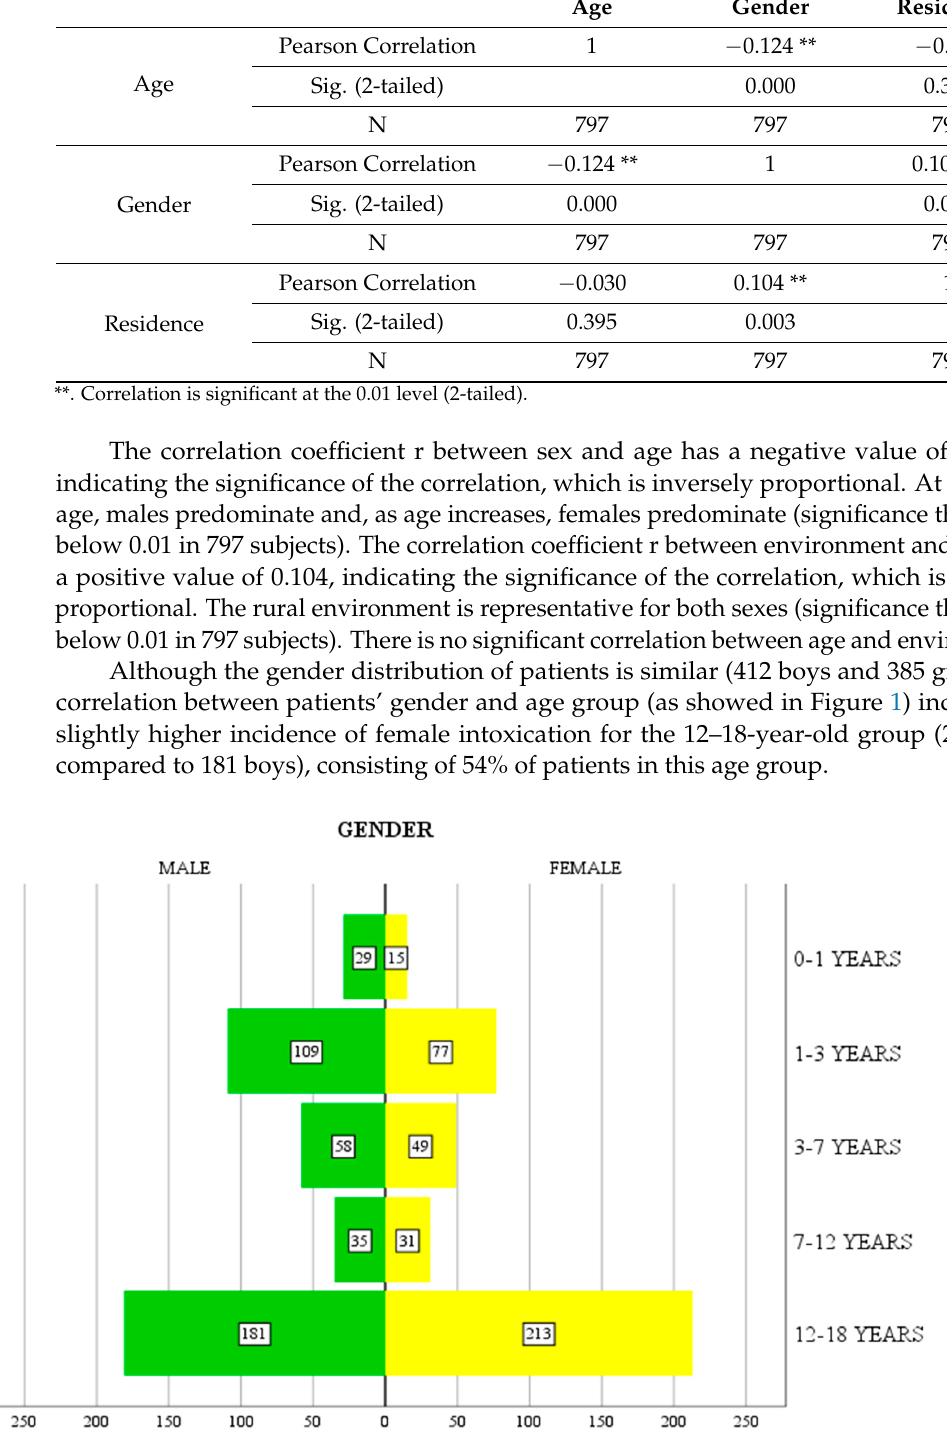
Figure 1. The correlation between the age groups and the sex of the patients. The rural environment is prevalent for all age groups, consisting of 525 patients out of 797 total (65.8%). The higher incidence of cases in rural areas is also reflected in the distribution for both sexes, such that 70% of boys (291 out of a total of 412 boys) and 60.7% of girls (234 out of a total of 385 girls) come from rural areas. From the analysis of the observation sheets, with the limits determined by the possi- bility that the cases were not documented, 104 (13.04%) particular situations were identi- fied as socially “stigmatized” cases. There is a possibility that the number of such cases may be higher, but these have not been documented in the observation sheets. There were 24 patients notified as school drop-outs, with 11 designated as social cases (disorganized families, family alcoholism, extremely poor environmental and living conditions) and 8 patients coming from care centers (institutionalized). All were in the 12–18 age group, presenting voluntary intoxication with substances including alcohol, psychodysleptic substances, marijuana, opiates and other drugs. There were also 24 patients who pre- sented with emotional and conduct disorders, and 10 patients with depressive-anxiolytic syndrome, all cases being diagnosed prior to presentation. In 20 cases, the patients had liminal intellect up to severe mental retardation, while 3 patients with autism were victims of accidental intoxication (2 cases in the age group 3–7 years and 1 case in the age group 7–12 years), and 1 patient with Down syndrome and 1 patient with polymalformative syndrome and mental retardation presented with iatrogenic intoxication. Out of a total of 385 female patients, 3 patients (0.779%) were pregnant in the first trimester of pregnancy (2 cases in rural areas and one case in an urban area), all three with voluntary intoxication for suicide reasons (toxicants involved included anticonvulsants, nonsteroidal anti-in- flammatory drugs, and hydrocarbons). The time elapsed from the time of exposure to the toxicant until the time of address- ing the ED directly influences the provision of specific medical care and consequently the patient ’ s response, hospitalization period and severity of the case. Most patients went to the ED a long time after exposure to the toxic substance, with an average of 3.53 h as shown in Figure 2.